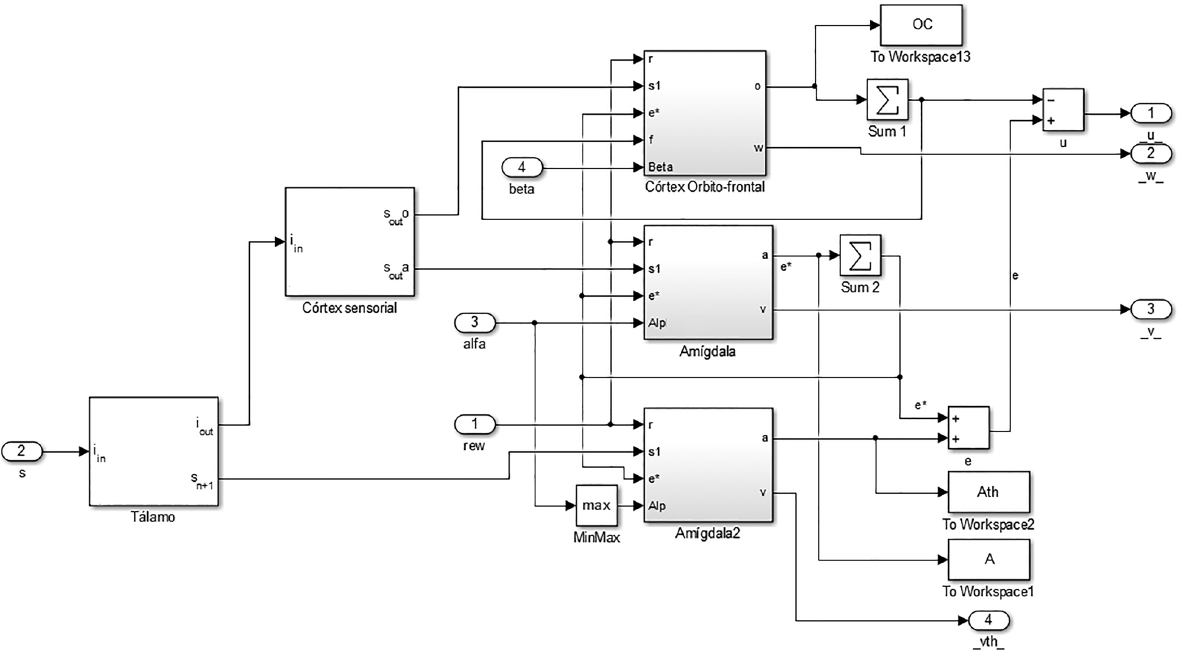
Figure 11. BELBIC controller block diagram.